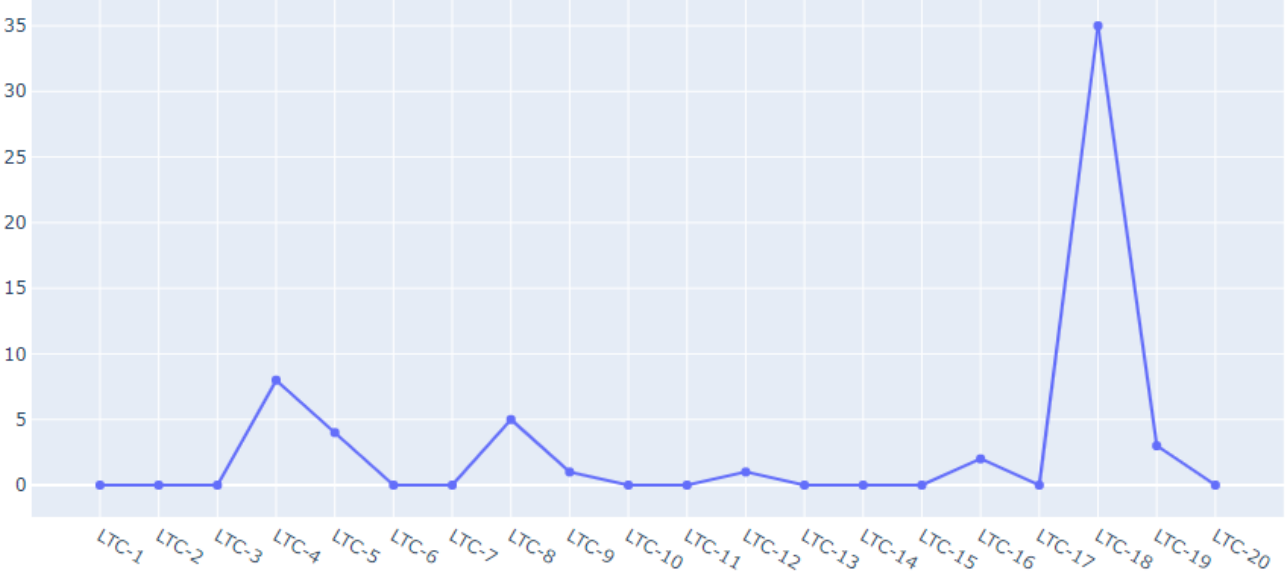
Figure 1. The number of residents using social networking before the COVID-19 pandemic.